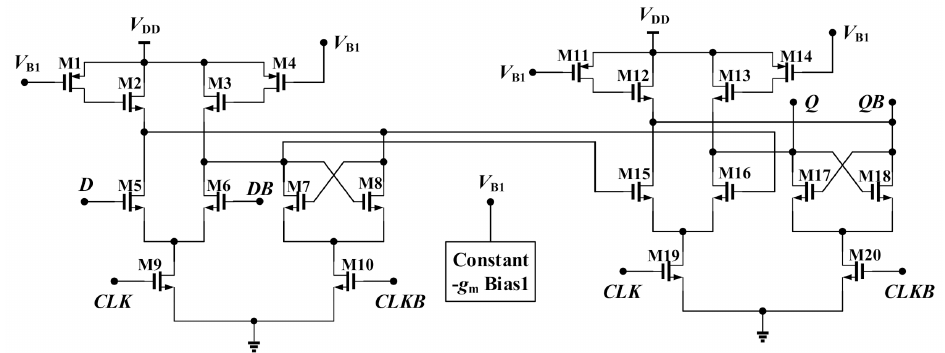
Figure 3. Schematic of the modified DFF based on active